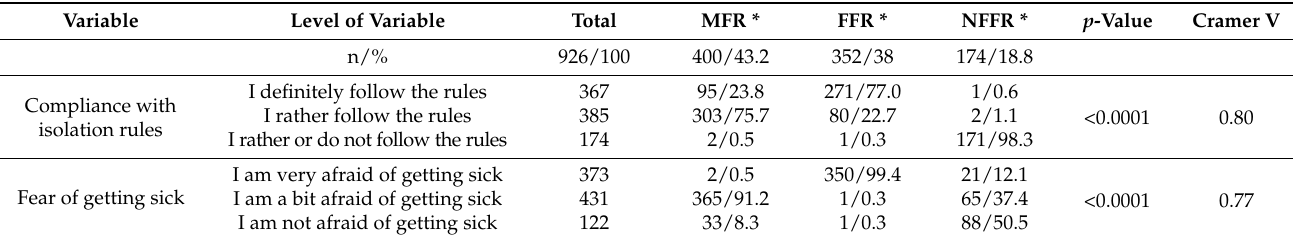
Table 1. Study population and isolated cluster characteristics including fear of getting sick and compliance with isolation rules.